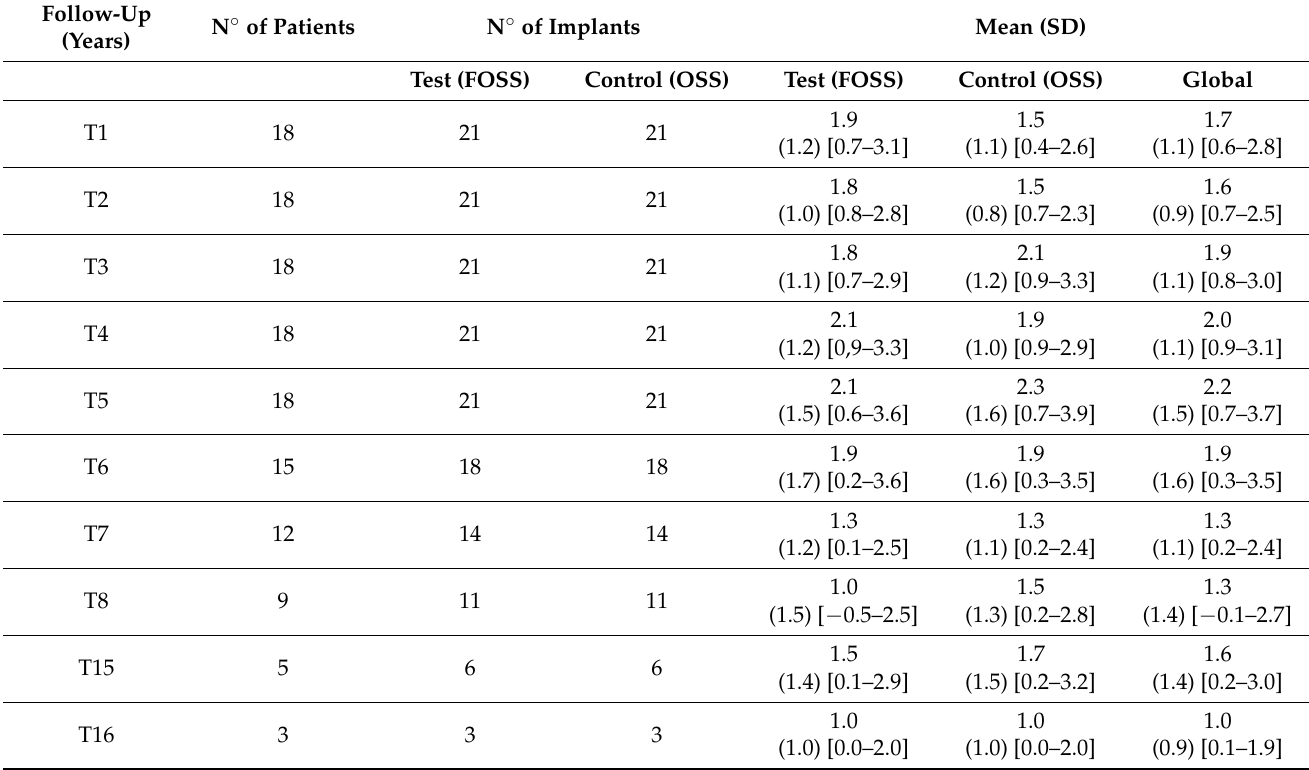
Table 5. Values of PI over time for OSS and FOSS